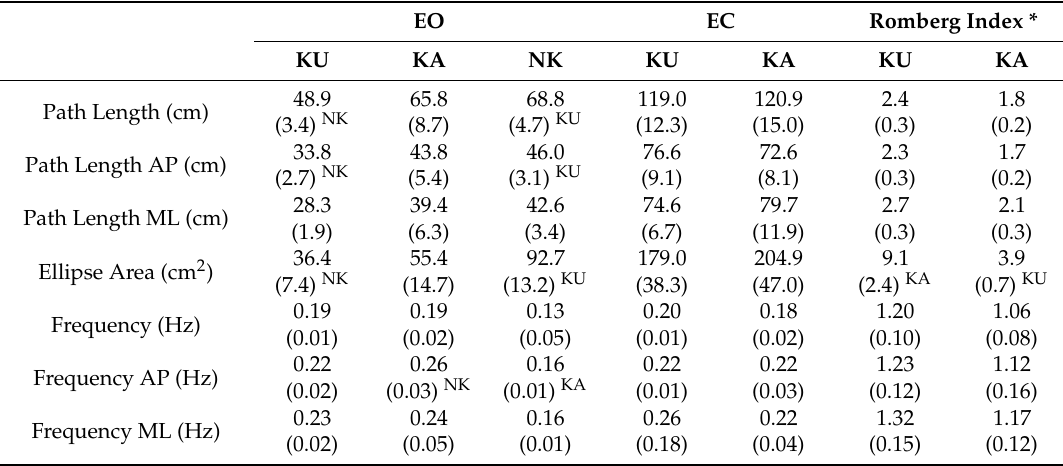
Table 3. Mean values (standard errors) for the body stability tests for all the examined groups. KU, KA, and NK stand for kumite, kata, and non-karatekas group, respectively. Superscripts represent statistical di ff erences. EO and EC indicate test performed with open and closed eyes, respectively. * Romberg Index (RI) is adimensional for each